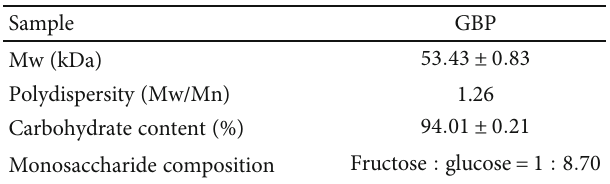
Table 2: The chemical analysis of polysaccharides from G. elata